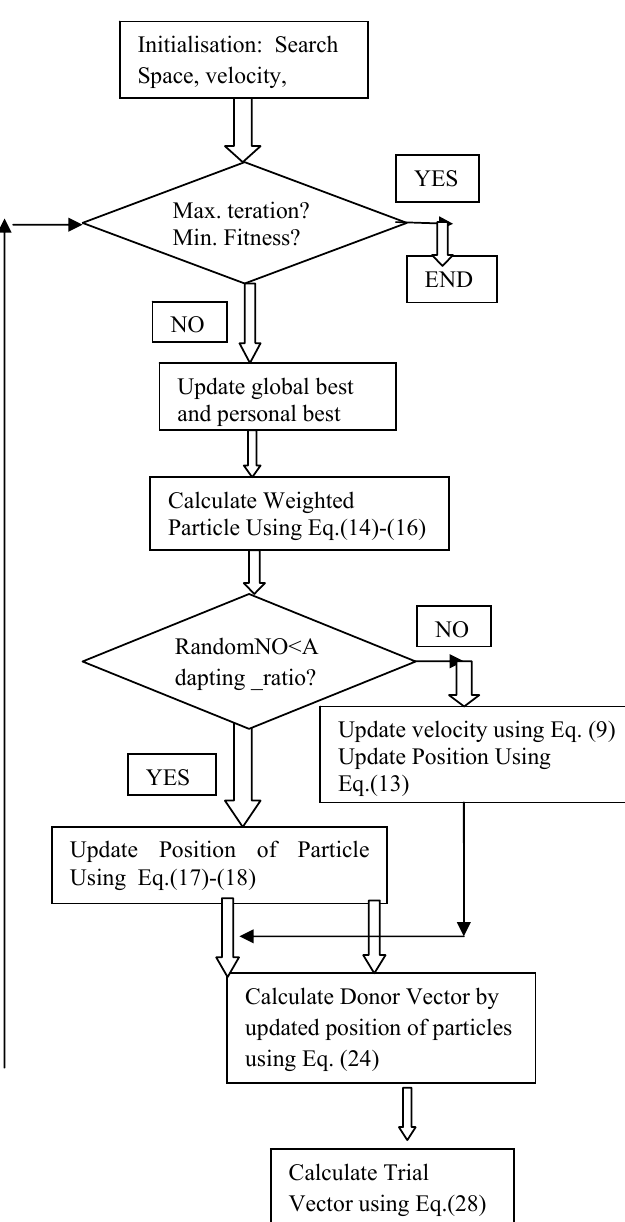
Figure1. Flowchart showing